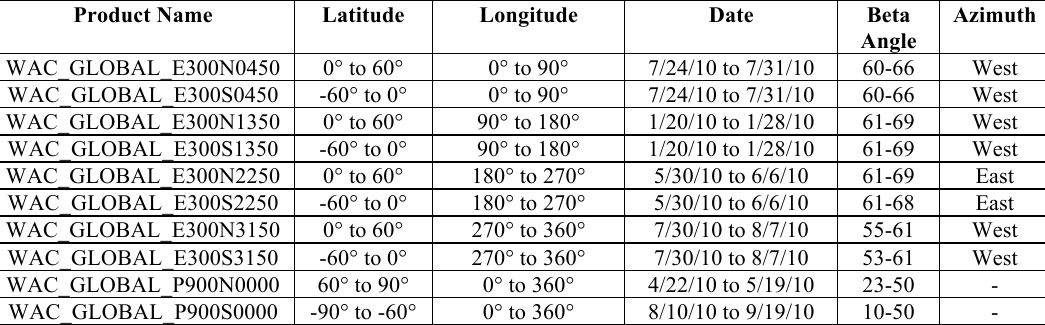
Table 1. LROC WAC global mosaic tiling scheme (E, P = equirectangular or polar; N, S = north or south).